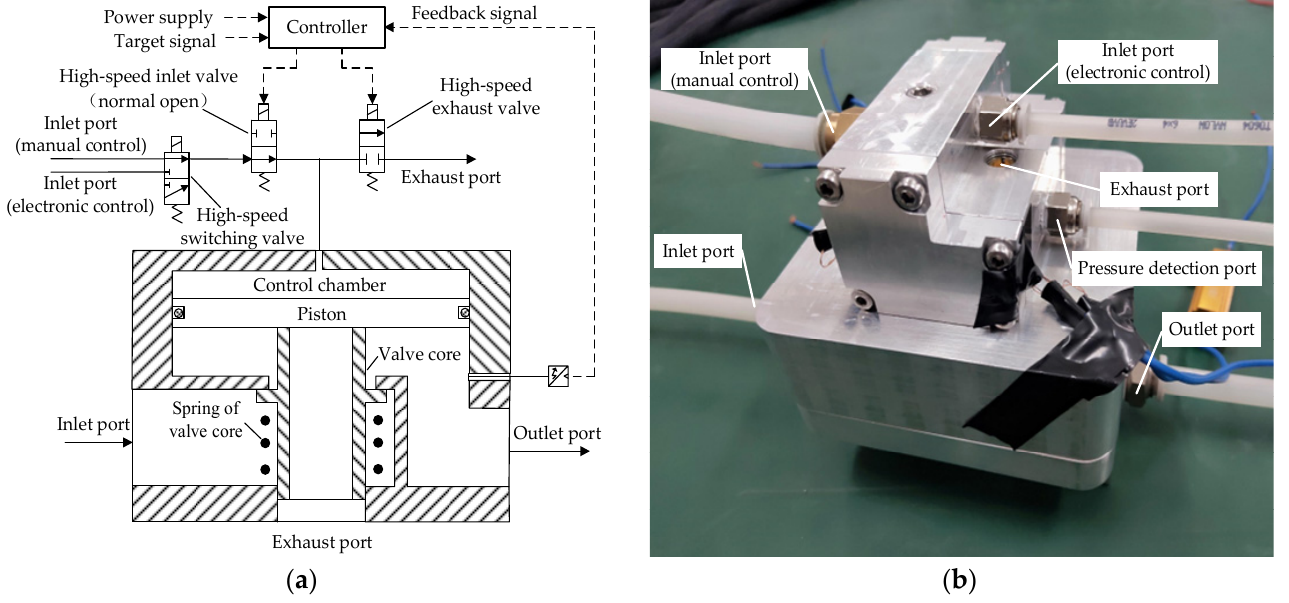
Figure 2. The LF-APRV in the ECPBS for driving automation of commercial vehicles: ( a ) principle drawing and ( b ) photograph.